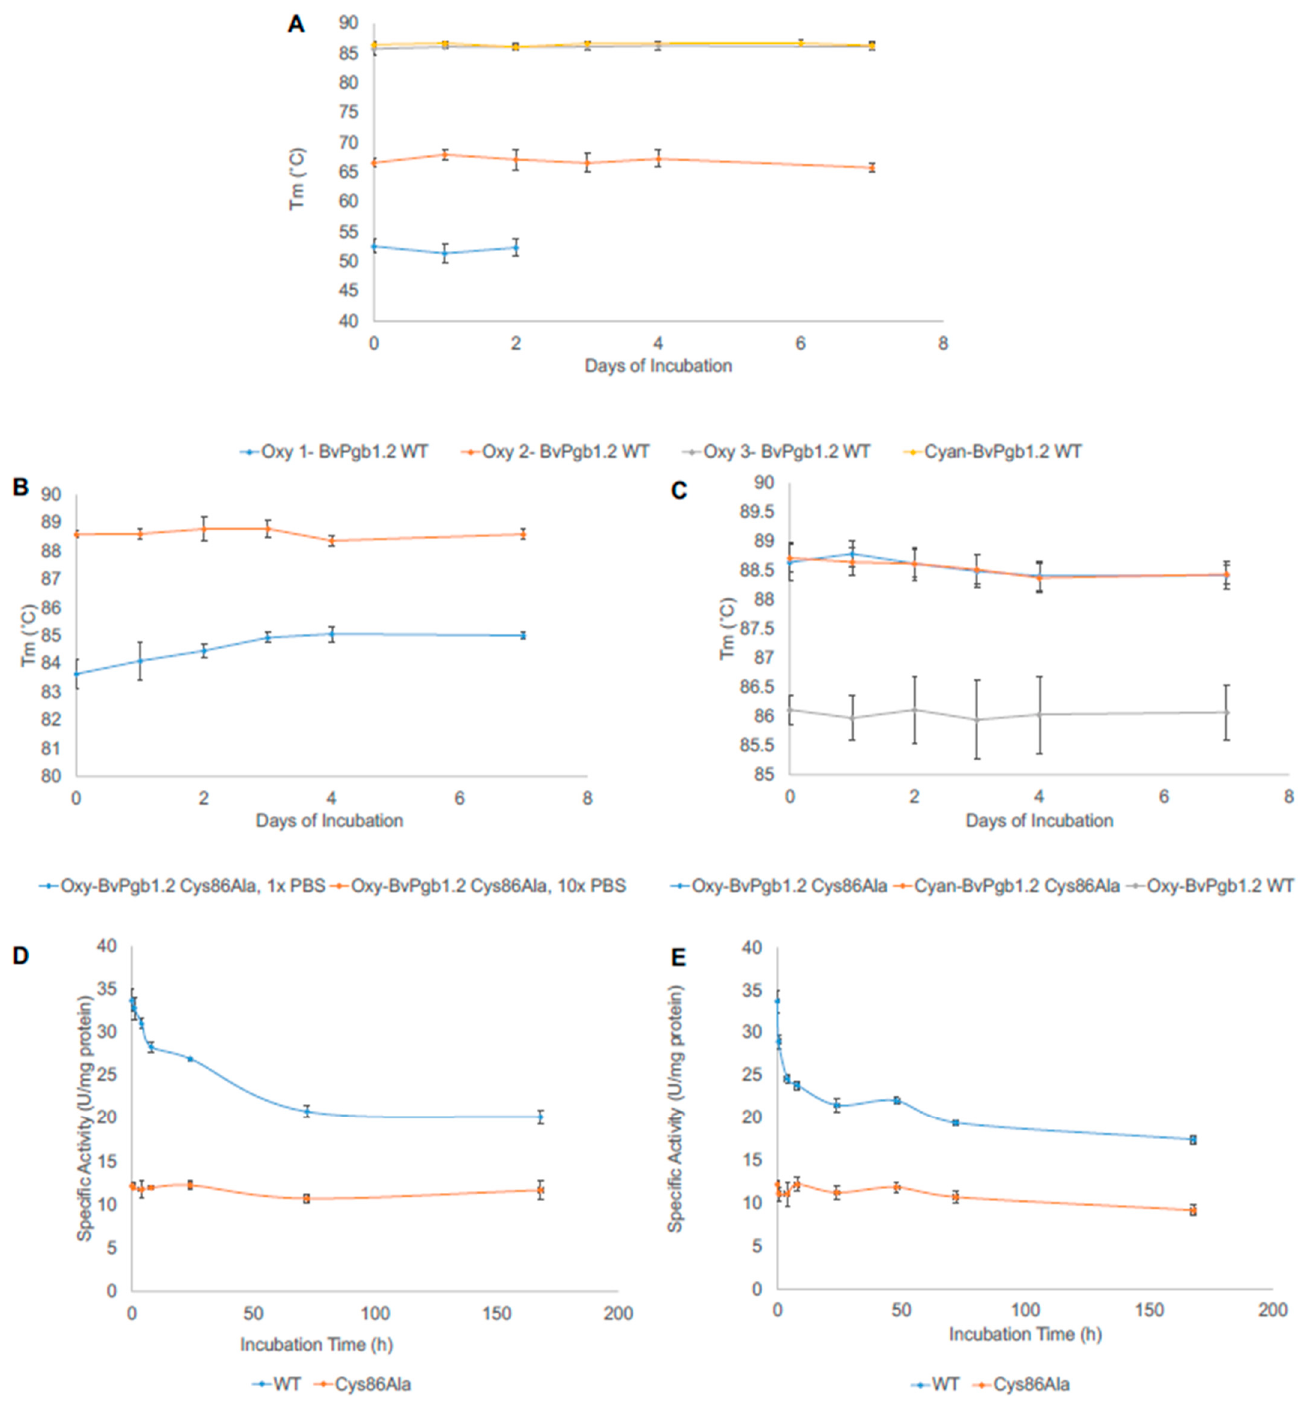
Figure 3. Thermal stability and peroxide activity measurements for BvPgb 1.2 and Cys86Ala. ( A ) Stability measurement for oxy- and cyanide BvPgb1.2 WT in 10× PBS at 25 °C during the 7 day incubation period. Three different transition states were detected (oxy 1, 2, and 3) for the first 2 days. The transition states for oxy 2 and 3 and cyanide was detected throughout the incubation period. ( B ) Stability measurement for oxy-BvPgb1.2 Cys86Ala in 1× and 10× PBS at 25 °C during the 7 day incubation period. ( C ) Stability measurement for cyanide- and oxy-Cys86Ala and oxy-BvPgb1.2 in 10× PBS at 37 °C during the 7 day incubation period. ( D , E ) Peroxidase activity for WT and Cys86Ala at 22 °C and 37 °C, respectively. The measurements were conducted in triplicate ( n = 3), and statis- tical significance ( p < 0.05) was determined using an unpaired t -test.